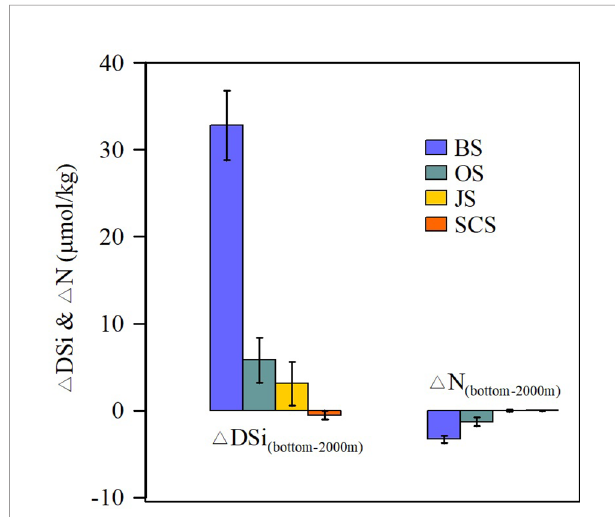
FIGURE 3 | D DSi (bottom – 2000m) (µmol/kg) and D N (bottom – 2000m) (µmol/kg) in the Bering Sea (BS), Okhotsk Sea (OS), Japan Sea (JS), and South China Sea